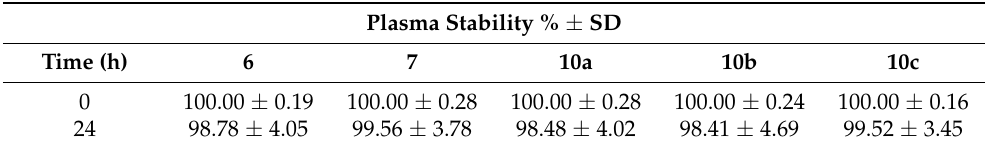
Table 4. Plasma stability studies after 24 h of compounds 6 , 7 , 10a–c